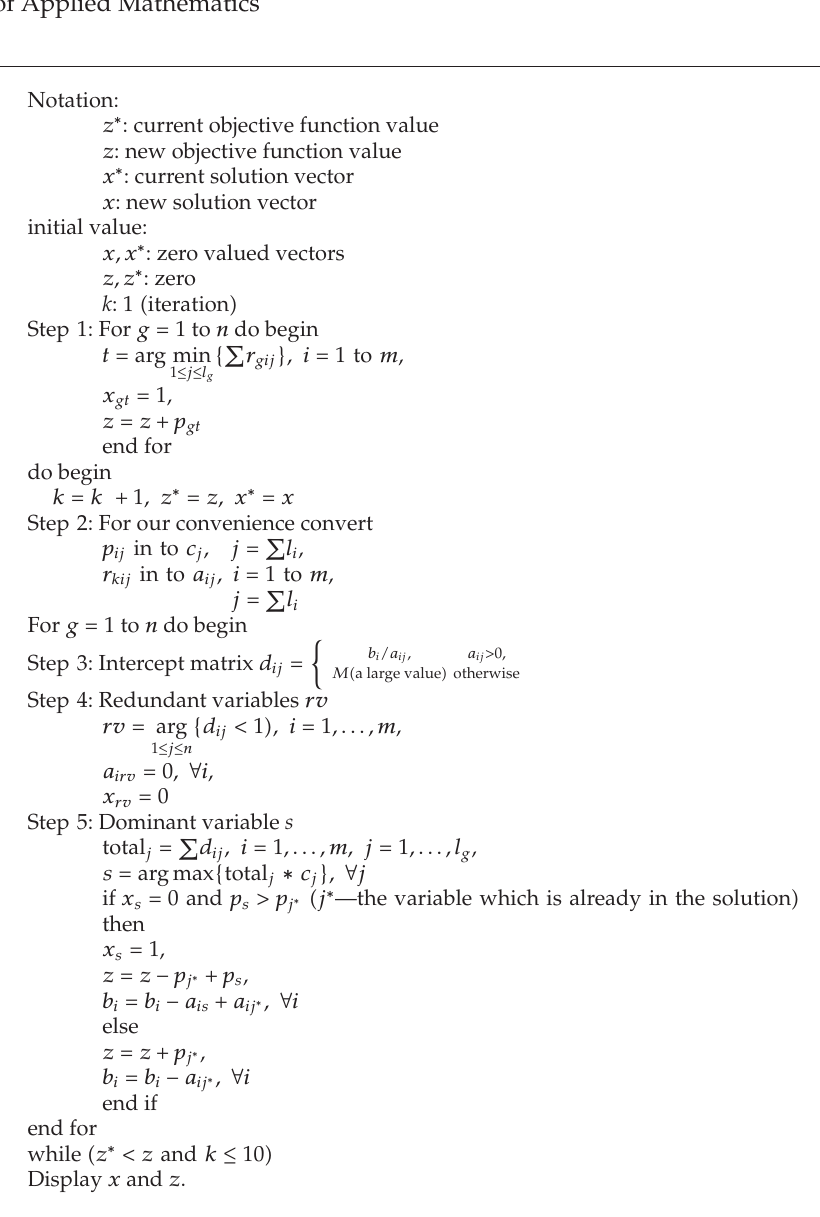
Algorithm 1: DPH algorithm for